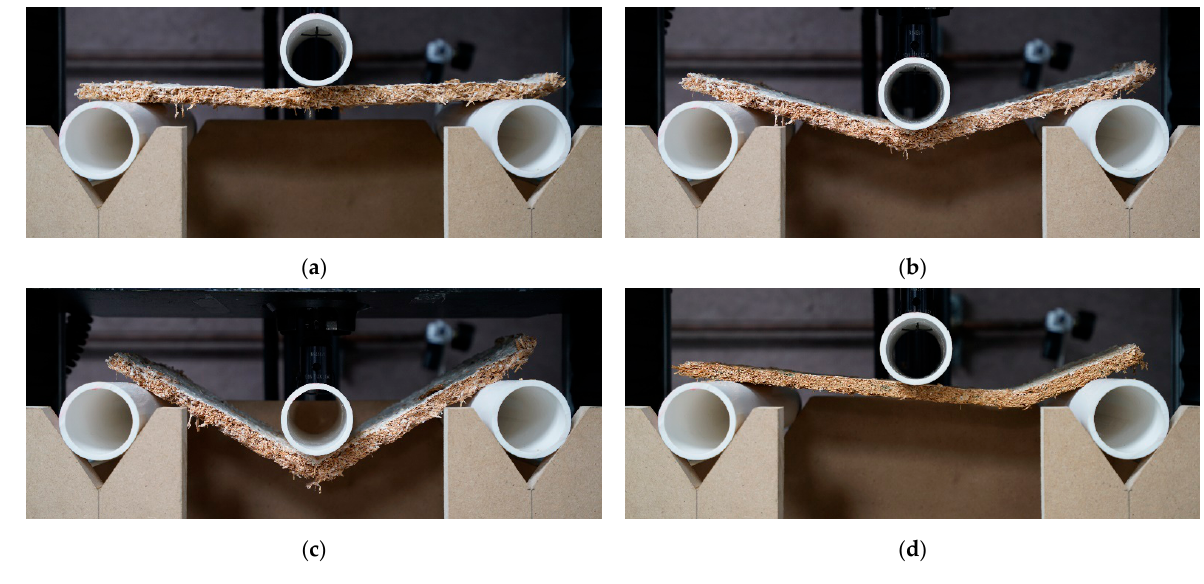
Figure 7. This figure shows the deformation of a PO_LNCB specimen throughout the bending test: ( a ) beginning of the test; ( b ) after 6 min and 25 s; ( c ) after 13 min (just before the end of the test). ( d ) shows the asymmetric deformation of a different specimen from the PO_LCD sample after 3 min.